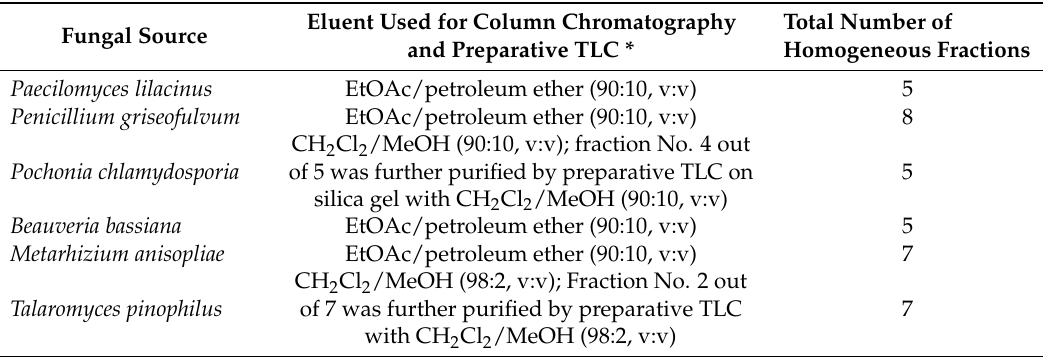
Table 5. List of solvents used for chromatographic separations (column chromatography or preparative TLC) and total number of homogeneous collected